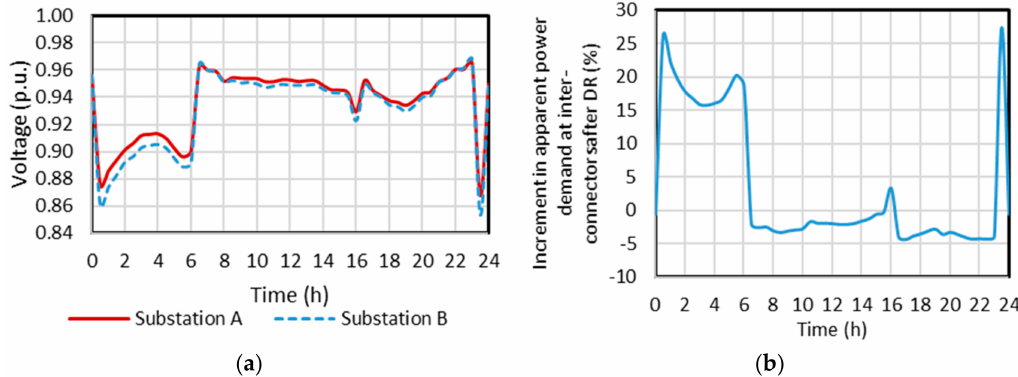
Figure 17. ( a ) Secondary voltage at transformers of both substations and ( b ) increment in apparent power flow through inter-connectors after the implementation of DR for scenario